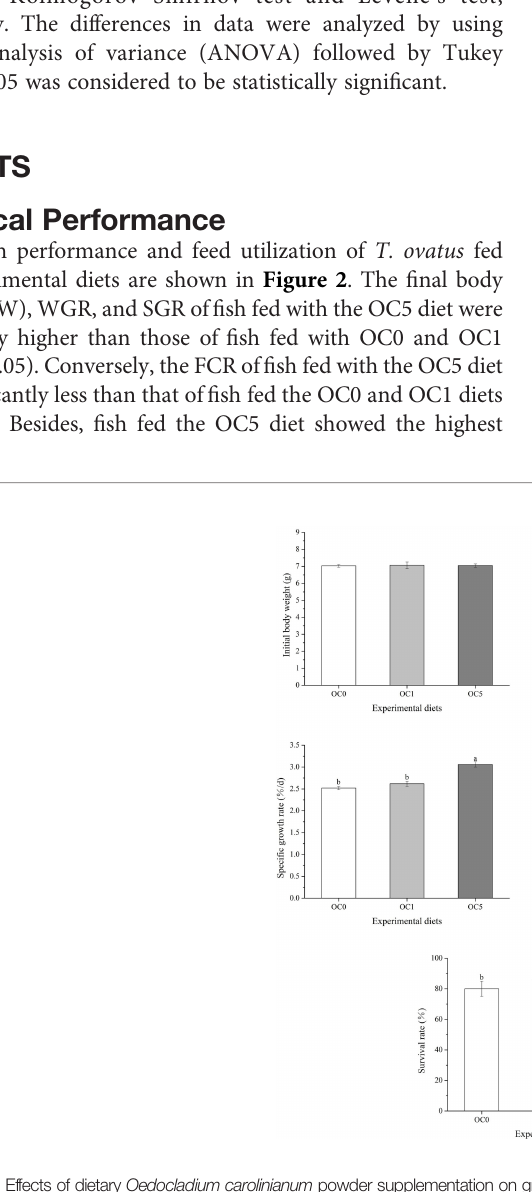
FIGURE 2 | Effects of dietary Oedocladium carolinianum powder supplementation on growth performance and feed utilization of T. ovatus after the 42-day feeding